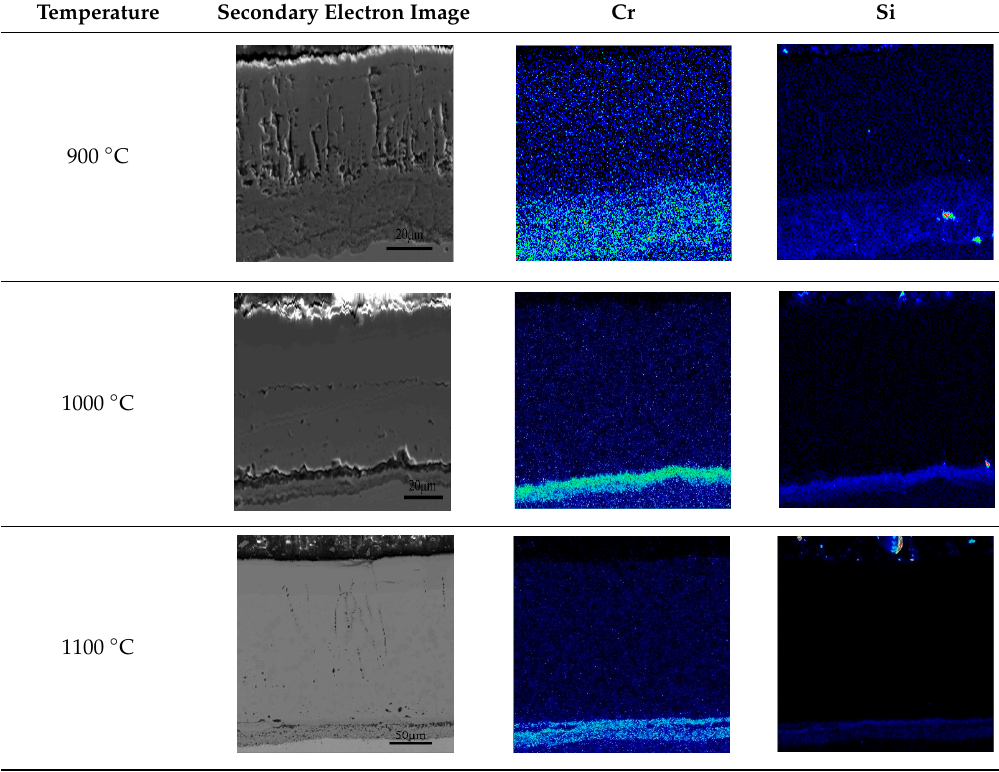
Table 5. K p values of the alloy obtained at different temperatures.